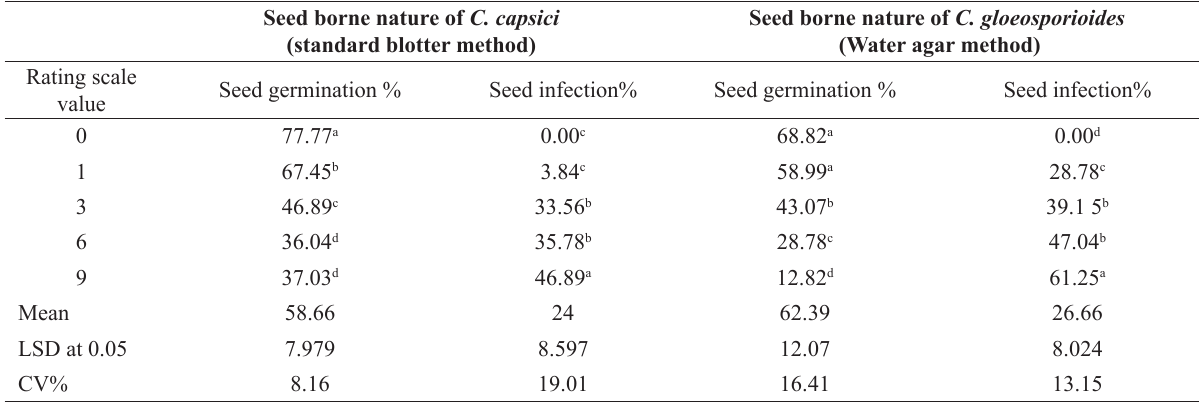
Table 3: Seed borne nature of C. capsici and C. gloeosporioides at different levels of infection. Seed borne nature of C. capsici